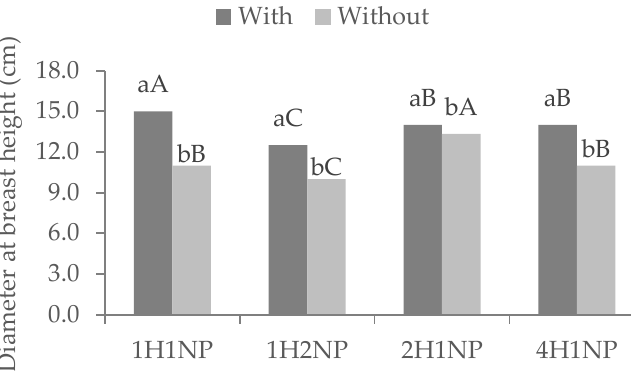
Figure 1. Diameter at breast height (DBH) of the trunk of the clone GG157, at 60 months of age, influenced by liming/fertilization (With or Without), height (H), in meter and number (NP) of poles per stump at the time of pole selection. Lowercase letters compare the effect of fertilization in the same treatment and uppercase letters compare the effect of the combination between height (H = 1, 2 or 4 m) and number of poles (NP = 1 or 2) left on the stump at the time of pole selection for the same fertilization condition (Tukey at 5%).